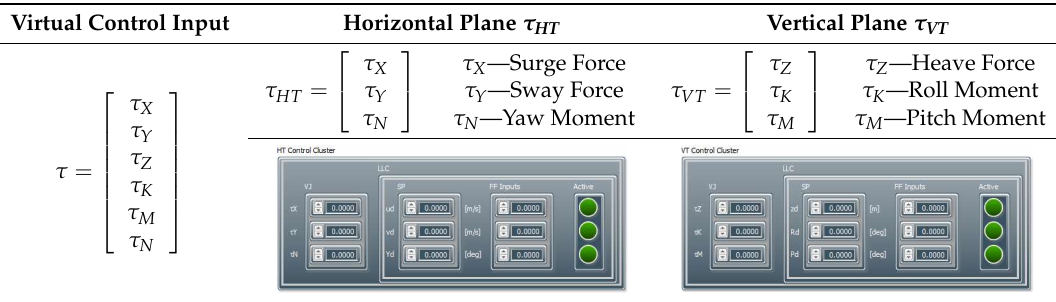
Table 2. Decomposition into Horizontal and Vertical Subspaces (Planes).